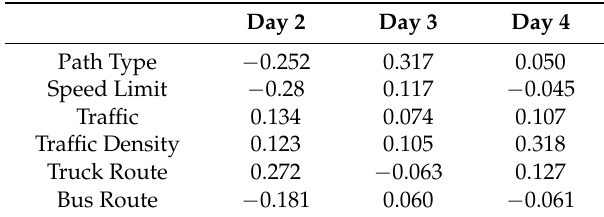
Table 5. Traffic-related predictor variables analyzed using ANOVA and Pearson’s R for correlation to PM 2.5 exposure.